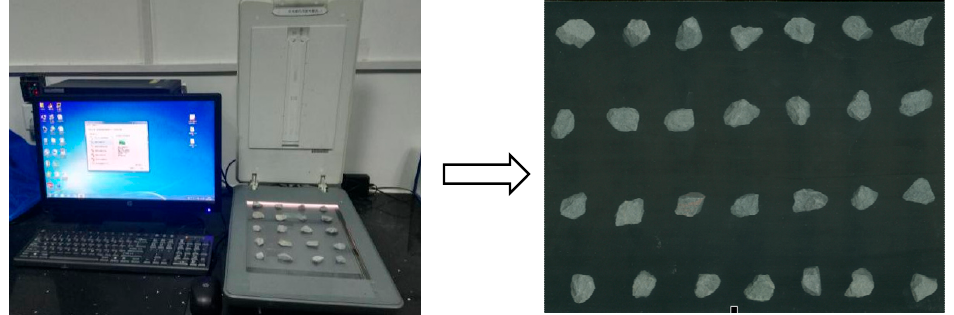
Figure 1. Aggregate particle image acquisition.